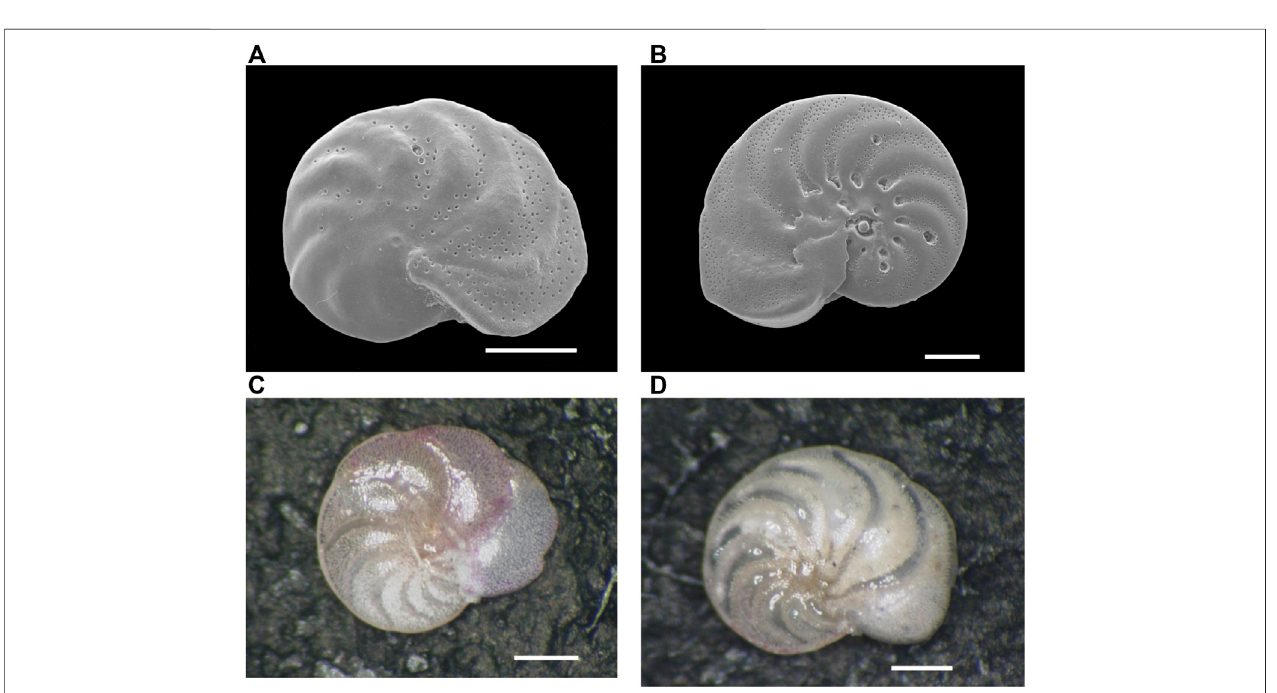
FIGURE2| ScanningElectronMicroscope(SEM)andstereomicroscopicimagesofthebenthicforaminifer Hanzawaianipponica (Asano)fromsurfacesedimentin Tosa Bay. (A) SEM image of living (stained) H. nipponica from site 25, (B) SEM image of living H. nipponica from site 5, (C) photomicrograph of living H. nipponica from site 5, (D) photomicrograph of fossil (non-stained) H. nipponica from site 25. Scale bars are 100 µm in (A) and (B) and 200 µm in (C) and (D) .